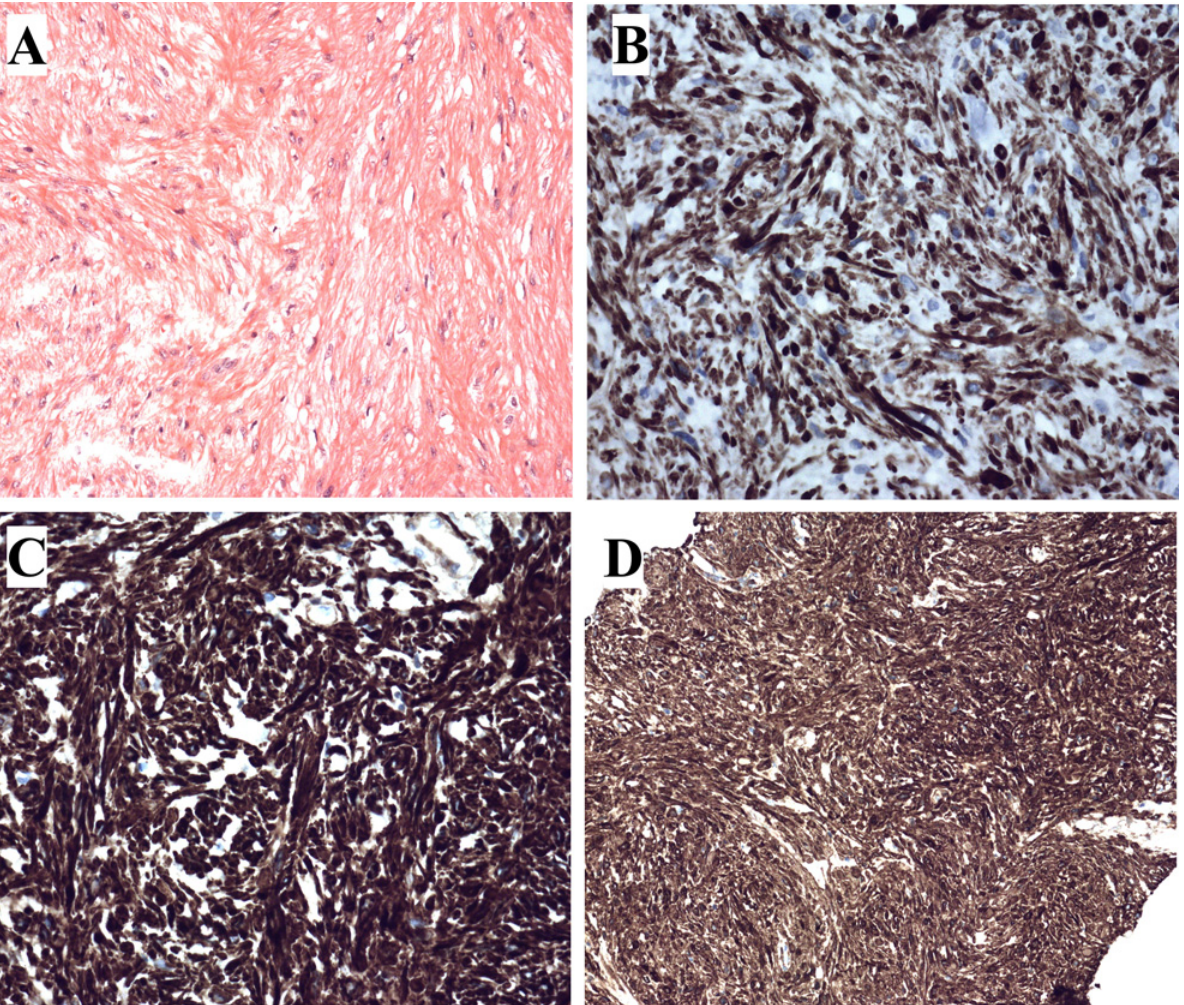
Fig 1. Histological examination of the retroperitoneal leiomyoma. A) HE-stained slide showing the tumor with spindle cells with eosinophilc cytoplasm without atypia surrounded by loose fibrous stroma. B) Immunoexpression of desmin. C) Immunoexpression of caldesmon. D) Immunoexpression of SMA.